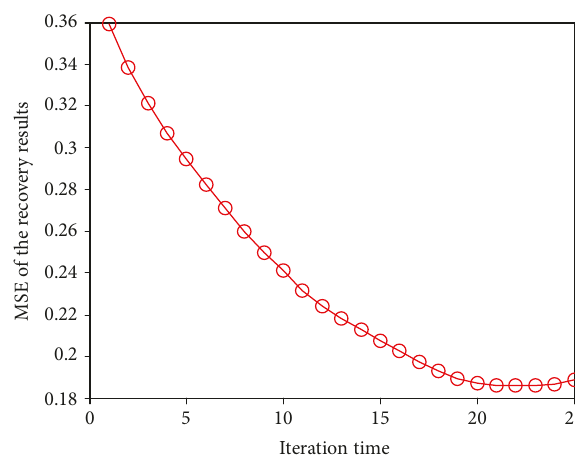
Figure 2: MSE curve with iteration time ( M = N = 15 , Q = 1 , SN R = 10 dB , σ t = σ r = 0 2 ). Table 1: The running time of each